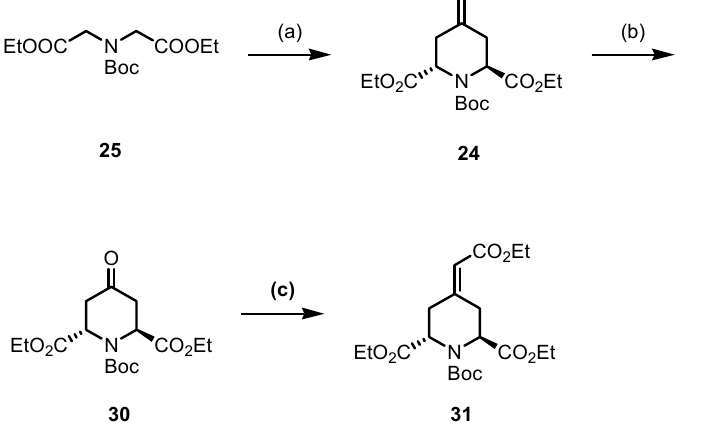
Scheme 8. Synthesis of α , β -unsaturated ester 31 . Reagents and reaction conditions were as